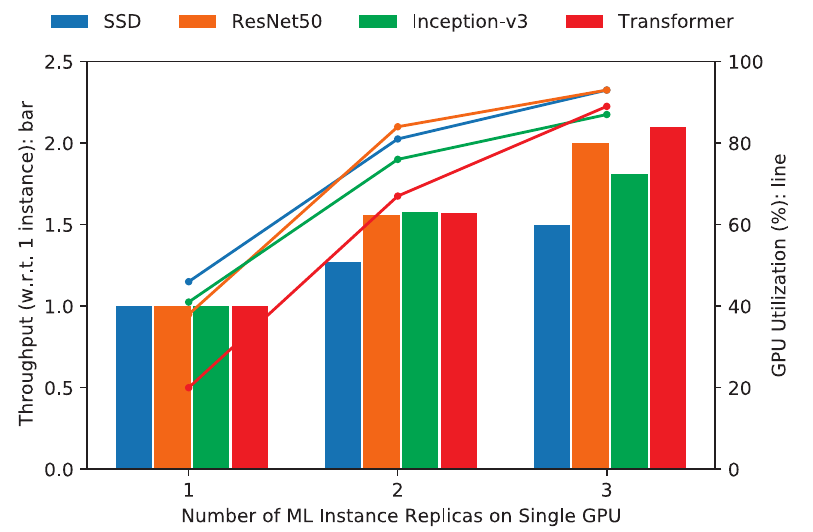
Figure 1. The serving throughput and GPU utilization with respect to the number of ML-instance replicas on a single